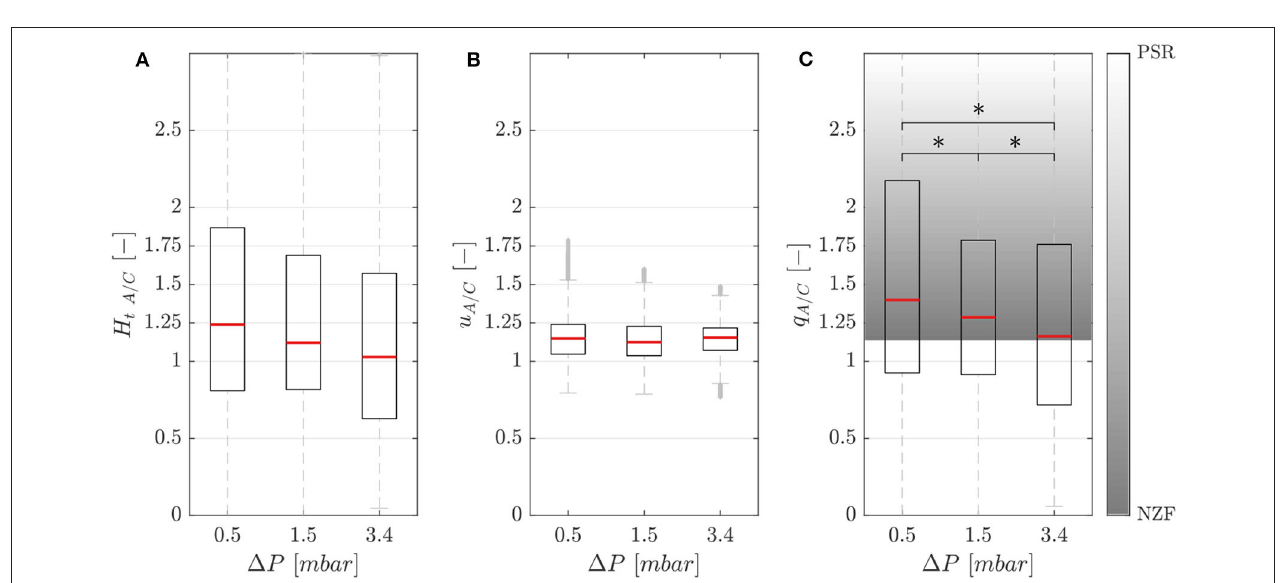
5 µ m (A) and t 2 10 µ m (B) . Data were = = are outliers). The RBC flux ratios in each + 0 bar . =